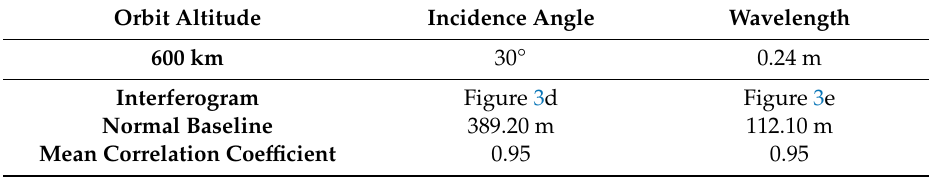
Table 1. The parameters of simulated interferometric synthetic aperture radar (InSAR) data. Orbit Altitude Incidence Angle